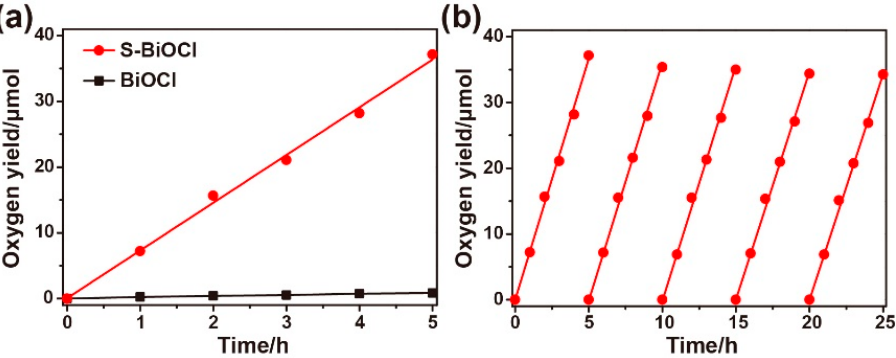
Figure 5. ( a ) The photocatalytic O 2 evolution activities of S-BiOCl and commercial BiOCl. ( b ) The cycling test of S-BiOCl.